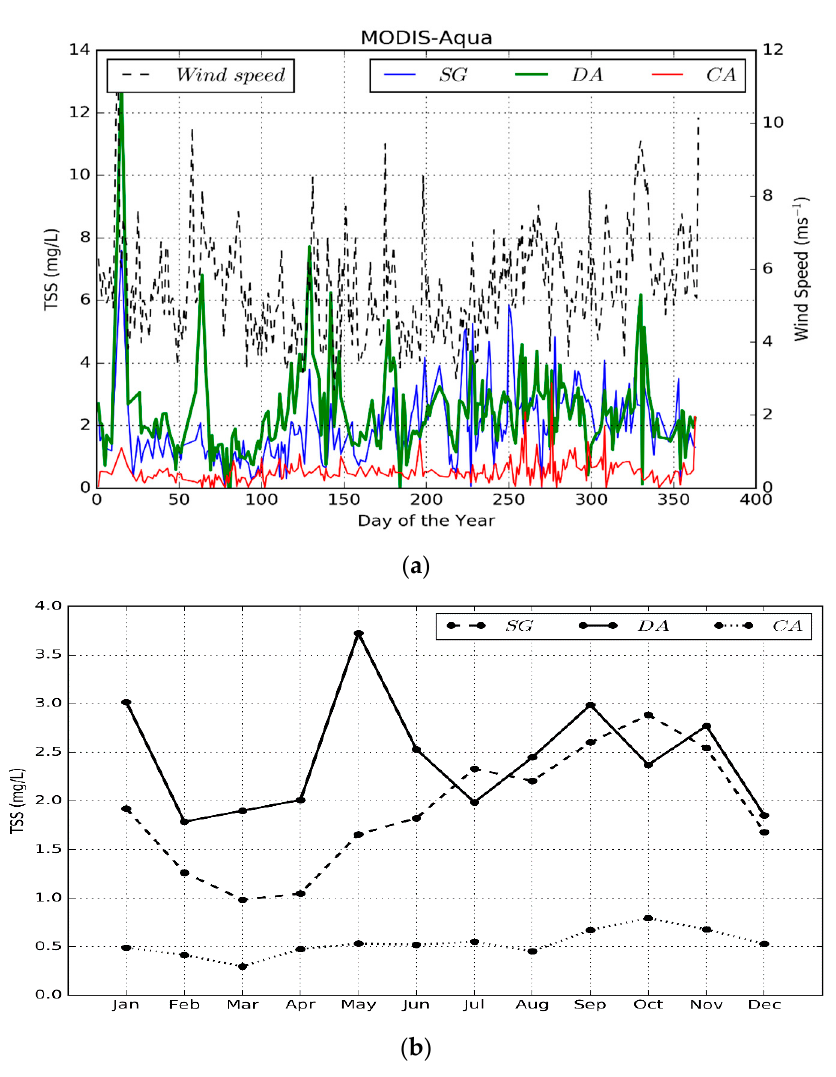
Figure 8. Daily ( a ) and monthly averaged ( b ) TSS derived from the SASM for 2013 MODIS-Aqua data.